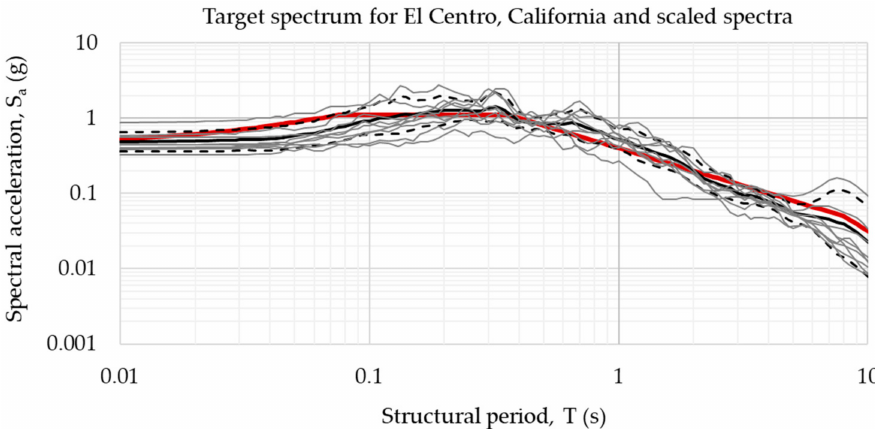
Figure 17. Example of the target spectrum for El Centro, CA, and scaled real earthquakes. According to the previous figure, the red line represents the target spectrum, the thick black line represents the geometric mean spectrum of the real earthquakes, and the thin gray lines represent the spectra of the 10 adjusted earthquakes. A good fit between the target spectrum and the mean values can be observed between 0.1 to 10